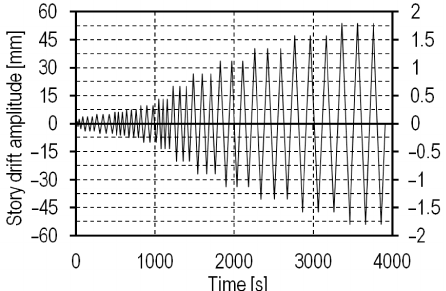
Fig. 4. Applied cyclic story drift time history for specimen